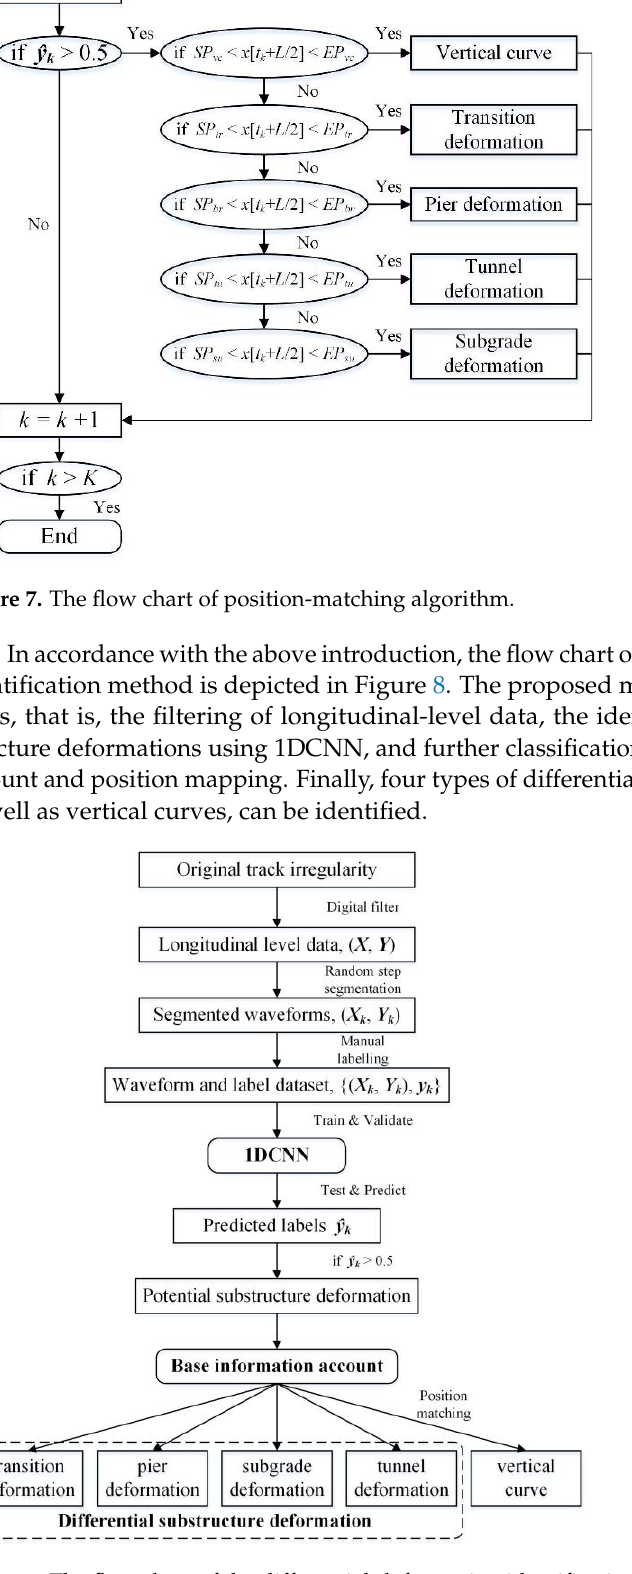
Figure 8. The flow chart of the differential-deformation identification method.